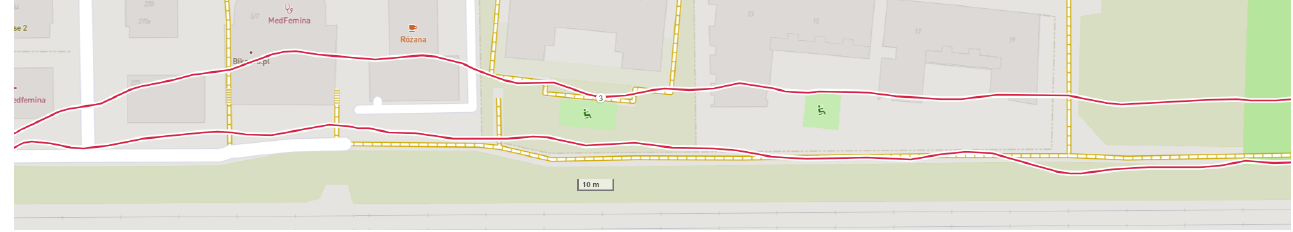
Figure 13. Runner route